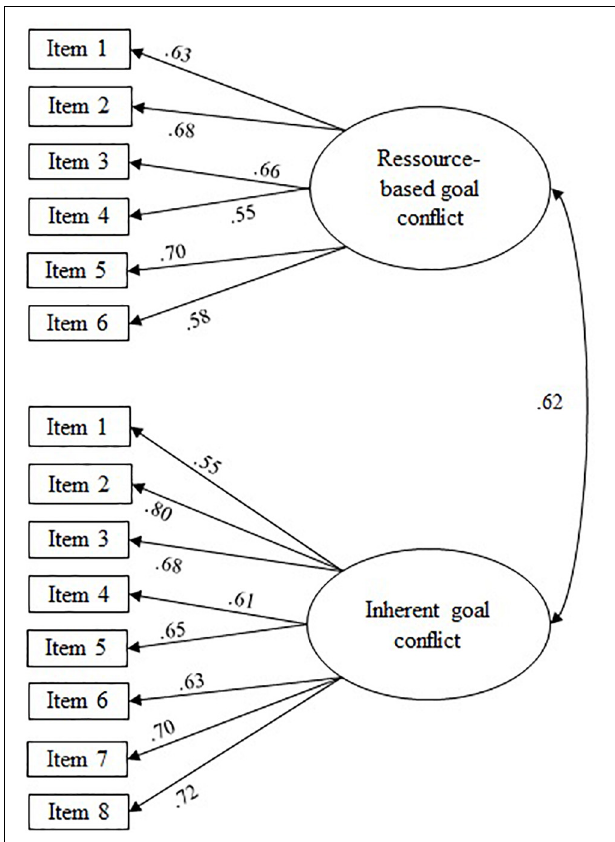
FIGURE 1 | Path coefficients from confirmatory factor analyses: two-factor model of frequency of experiencing goal conflict. Figure depicts standardized loadings; all loadings and correlations are significant ( p < 0.05); correlations between latent variables were specified as residual error correlations.